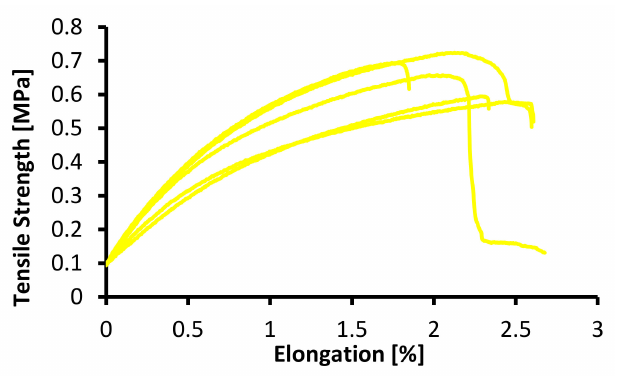
Figure 8. Tensile strength–elongation graph for 17.5 wt% PVDF with 1% tin dioxide.